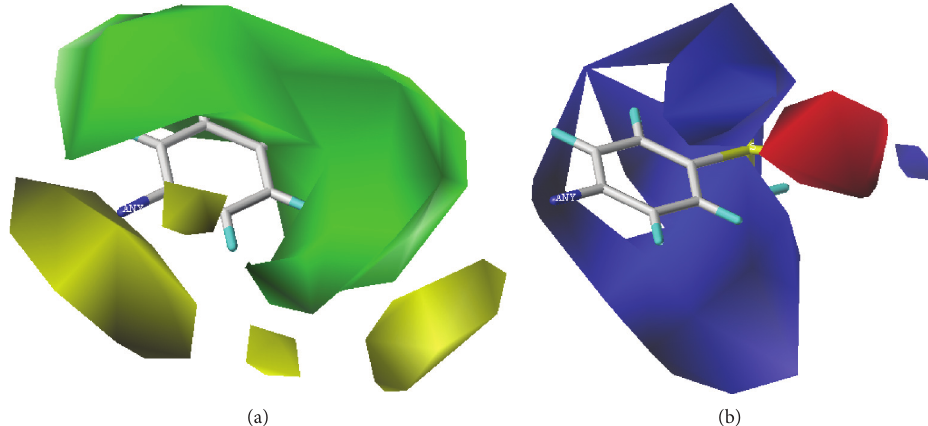
Figure 3: Molecular field contour map pertaining to the R2 fragments using compound 22 as the reference. (a) Steric contours of the R2 fragment. (b) Electrostatic contours of the R2 fragment. Yellow contours imply that less steric hindrance is favourable, while green polyhedra indicate that the sterically bulky group is beneficial. Blue contours signify that the electron-donating groups are favored, while red contours reveal that the electron-withdrawing substituents are preferred. Table 3: Newly designed molecules and predicted anti-LOX potency. Predicted Novel compounds pIC